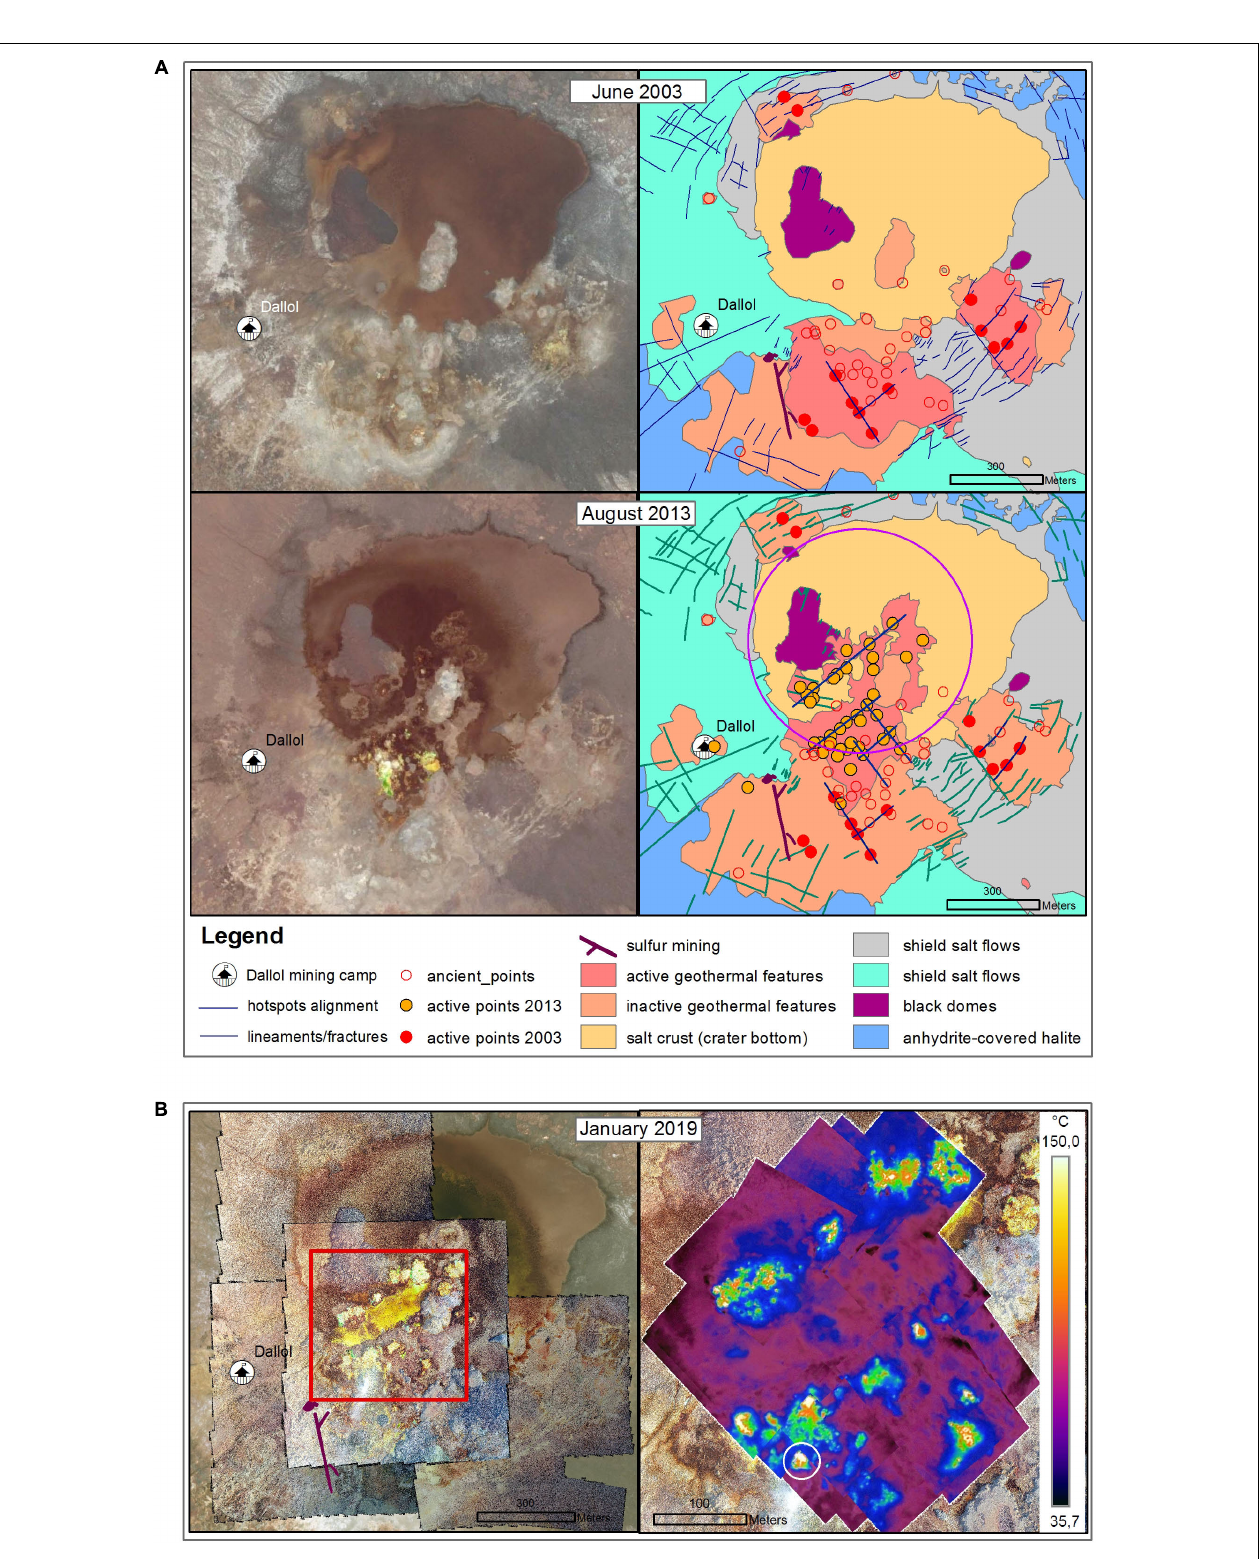
FIGURE 10 | Evolution of the geothermal activity on the Dallol dome. (A) Activity before and after the intrusion dyke event of October–November 2004 (right) inferred from detailed satellite images from Google Earth (left). Purple circle (right) draws probable subsidence area after the 2004 event. (B) Recent activity seen on January 2019 using high-resolution drone images (left) and infrared images (right). Red square (left) shows the area covered by IR images (right).